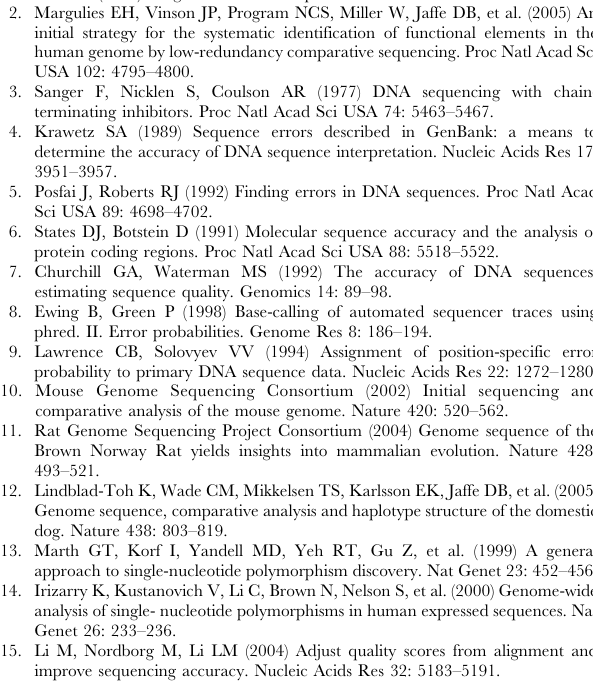
Table S2 Summary of alignments of 2 6 genomes and corresponding ENCODE sequences.